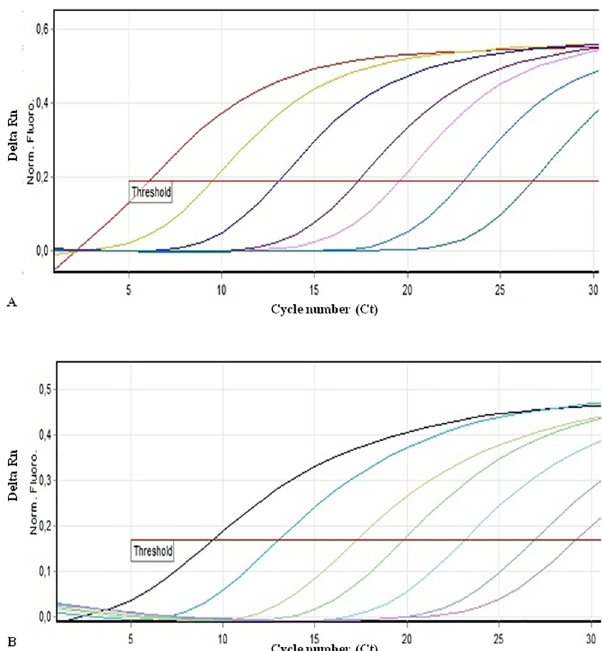
Fig 2. Multiplex qPCR amplification of seven 10-fold serial dilutions of 16SrII (A) and 16SrIX (B) group phytoplasma DNA (purified PCR products). The amplification mixture contained phytoplasma and sesame primers and probes. Each dilution series was mixed with a constant 10 ng (2 μ l) of healthy sesame plant DNA in each reaction to determine whether PCR inhibitors were present. Each line represents one of the experiment made in triplicate. Delta Rn ( Δ Rn) values show the fluorescence emission accumulation normalized to the background emission. Cycle threshold (Ct) values indicate specific cycles at which Δ Rn passes the threshold value.